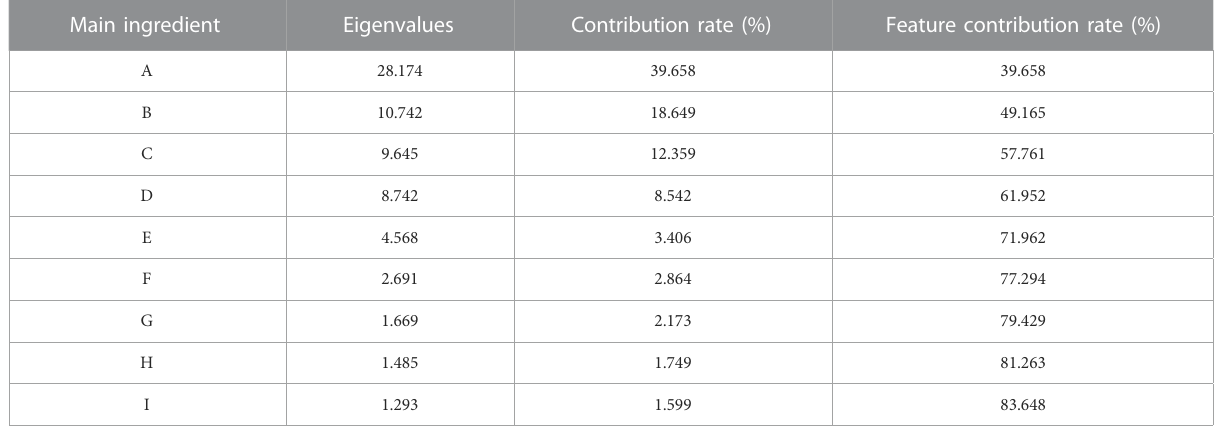
TABLE 3 List of principal component characteristic data of public genes. Main